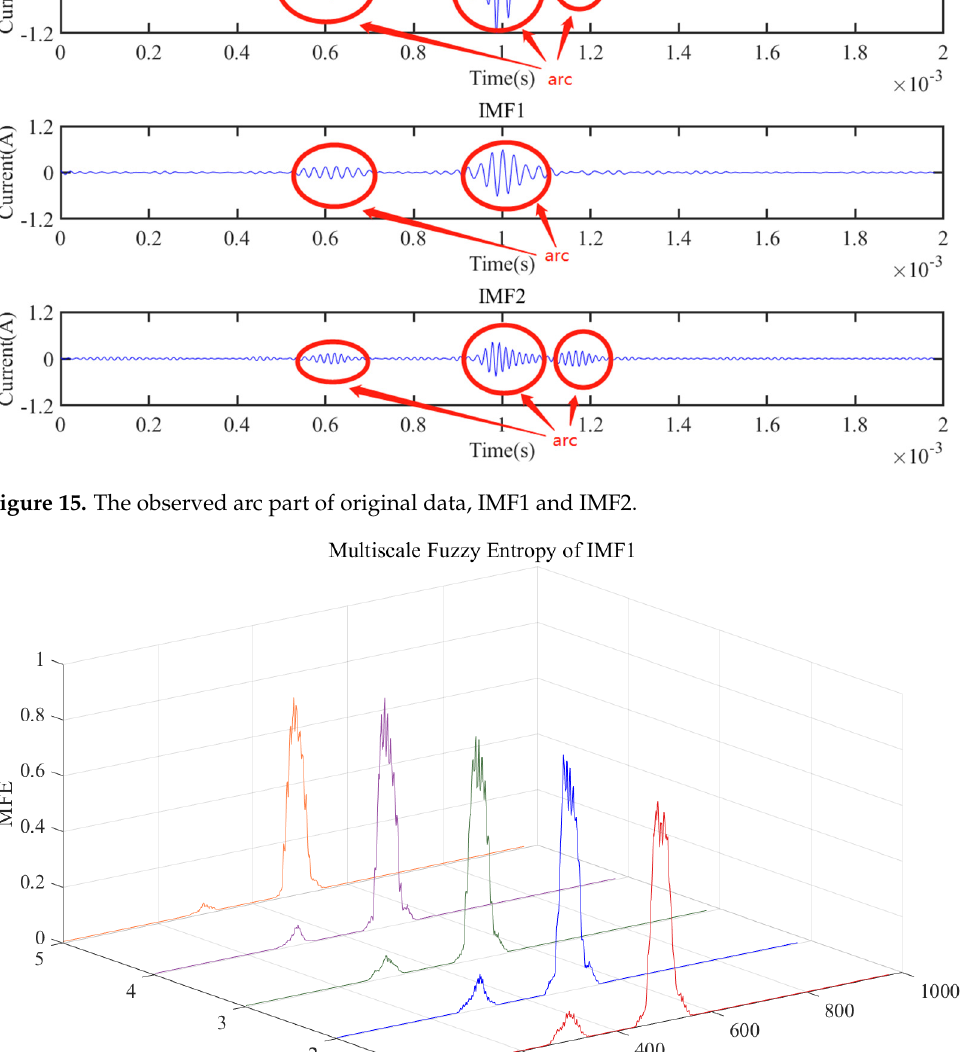
Figure 17. IMFE under different scales of IMF2. By combining Figures 15–17, the IMFE successfully met the requirement of the fea- tures of arc diagnosis. The value of IMFE was close to 0 when an arc fault did not happen. Once an arc fault occurred, the value of IMFE increased noticeably, and the magnitude was proportional to the severity of the arc fault. Before conducting validation, the choices of τ and N need to be discussed. The IMFE calculation above was conducted when τ was less than 5. When the length of the sliding window and the length of the factor are chosen differently, the result could be different. Figure 18 shows the average IMFE-scale curve when the length of the sliding window is chosen as 100, 75, or 50. The IMFE is calculated from IMF1 in Figure 18.